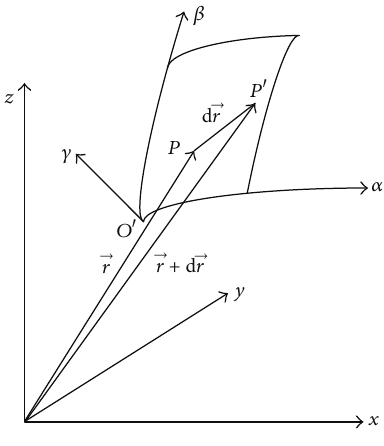
Figure 1: The coordinate